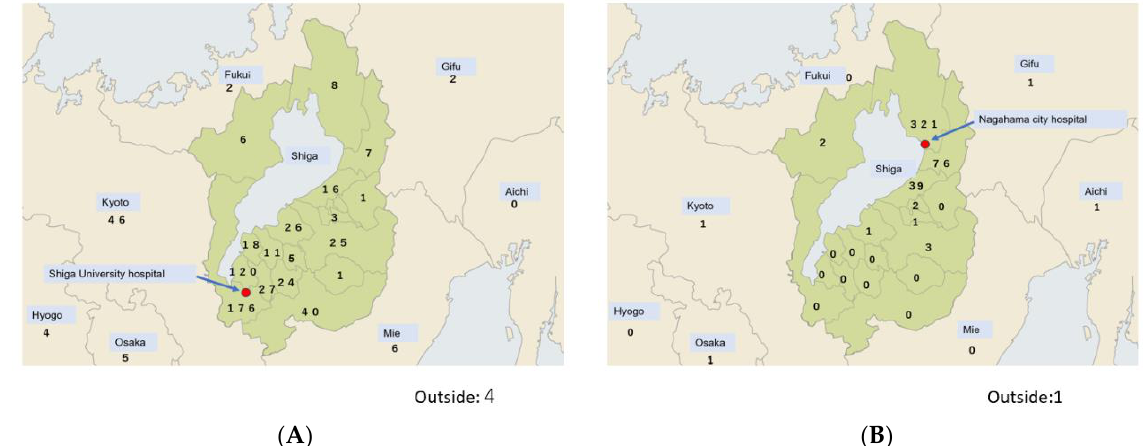
Figure 1. Distribution of new patients in the two settings studied. The numbers of new patients who visited each sleep outpatient unit from 1 April 2015 to 31 March 2019 at Shiga University of Medical Science Hospital ( A ) and Nagahama City Hospital ( B ) are indicated. The green areas represent Shiga Prefecture. Within Shiga Prefecture, each city or county is indicated separately. Prefectures outside Shiga Prefecture are also presented separately. The red circles indicate the locations of the two hos- pitals.